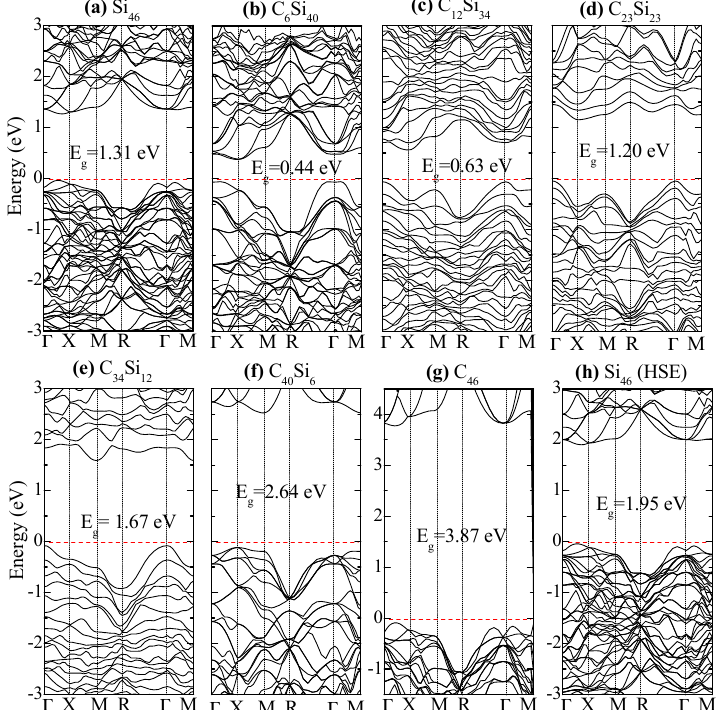
Figure 10. Electronic band structures of ( a ) Si 46 , ( b ) C 6 Si 40 , ( c ) C 12 Si 34 , ( d ) C 23 Si 23 , ( e ) C 34 Si 12 , ( f ) C 40 Si 6 , and ( g ) C 46 predicted by the density functional theory (DFT). ( h ) The band structure of Si 46 predicted using the Hyed–Scuseria–Ernzerhof (HSE) hybrid functional. The corresponding band gaps are denoted. The Fermi level (red dashed line) is referenced at the top of the valence band at zero eV. From Chan and Peng [24]. Reprinted with permission from Springer.